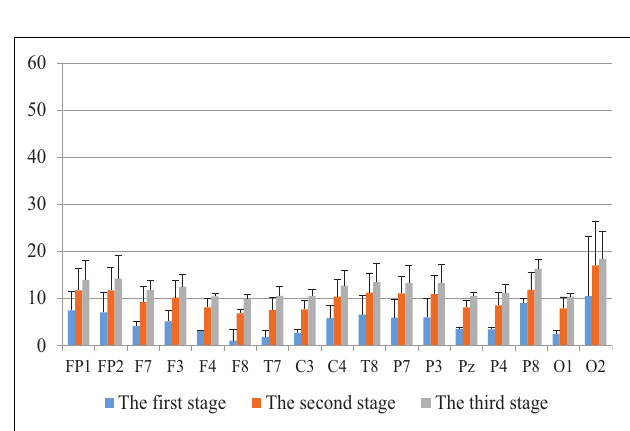
FIGURE 7 | The characteristics of gamma wave power changes in whole brain regions of anxious subjects in the three experimental stages.